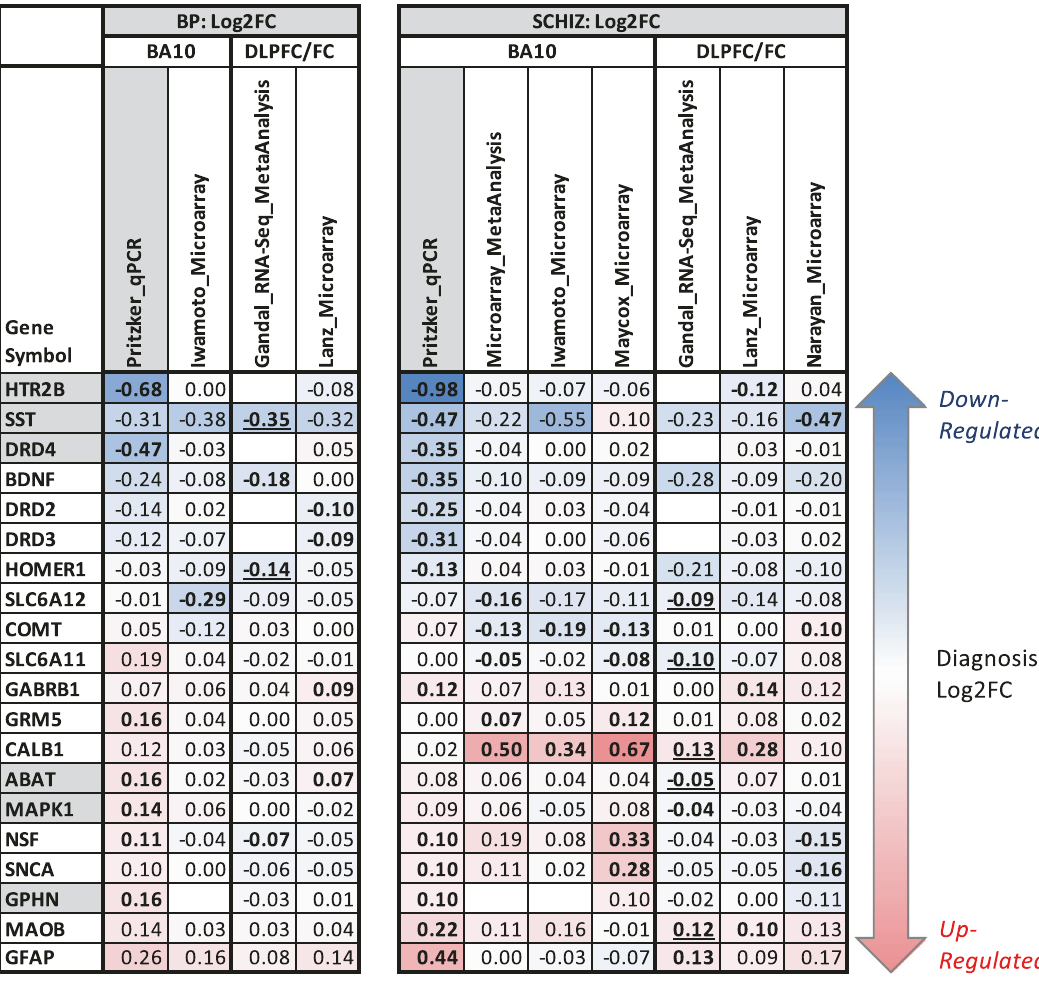
Fig. 3 A table overviewing the most supported effects of diagnosis on neurotransmission-related gene expression in BA10. The table illustrates the effects of diagnosis (Log2FC, left: BP, right: SCHIZ) on neurotransmission-related gene expression as identi fi ed in our BA10 qPCR experiment (column highlighted in grey), our re-analysis of two BA10 microarray datasets (Iwamoto et al. [20] and Maycox et al. [20]), and our meta-analysis of the SCHIZ results from the two BA10 microarray datasets. These results often paralleled results from adjacent frontal cortex: a large meta-analysis of RNA-Seq data from the DLPFC/FC (Gandal et al. [34]) and results from two smaller microarray datasets from the DLPFC with grey matter-focused dissections (Lanz et al. [36] and Narayan et al. [35] as re-analyzed by Hagenauer et al. [37]). Note that we did not include the results from the large Gandal et al. [34] meta-analysis of microarray data because it was from a more broadly de fi ned anatomical region ( “ cortex ” ) and included data from the Maycox et al. [21], Lanz et al. [36], and Narayan et al. [35] studies already in the table. To be included in the table, a gene needed to show strong evidence of differential expression in BA10: either FDR < 0.10 in our BA10 qPCR experiment (gene symbol with grey shading) or P < 0.05 (Log2FC in bold text) and consistent direction of effect in two independent datasets from BA10 or in a BA10 dataset and DLPFC/FC dataset. Throughout the table, red is used to indicate upregulation and blue is used to indicate downregulation. Empty cells indicate that the expression for that gene was either not quanti fi ed (GPHN) or considered to be unquanti fi able (HTR2B, DRD2/3/4) in the dataset. Complete statistical reporting for the full results from our BA10 qPCR experiments, our re-analysis of the Iwamoto et al. and Maycox et al. BA10 microarray datasets and BA10 microarray meta-analysis can be found in Supplementary Tables S5 and